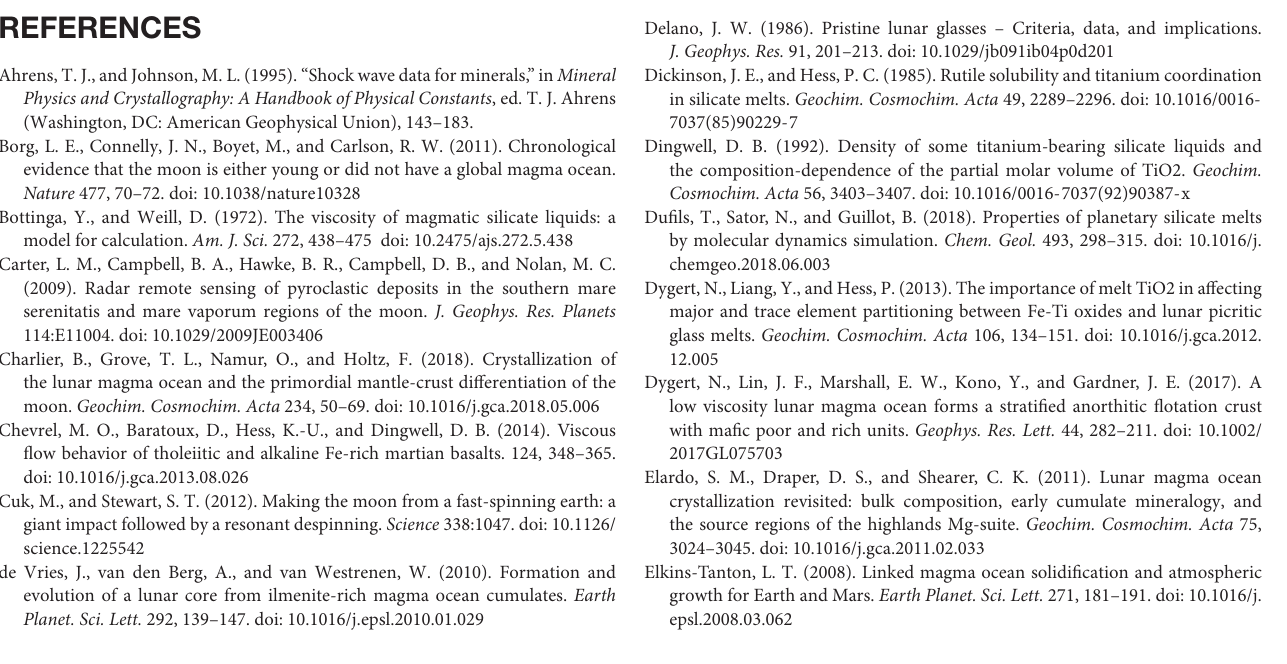
FIGURE S1 | X-ray intensity scattered by the green, orange, and black molten glasses under similar conditions of 1.2 ± 0.2 GPa and 1850 ± 50 K. The first sharp diffraction peak (FSDP) position is shifted to higher Q with increasing Ti